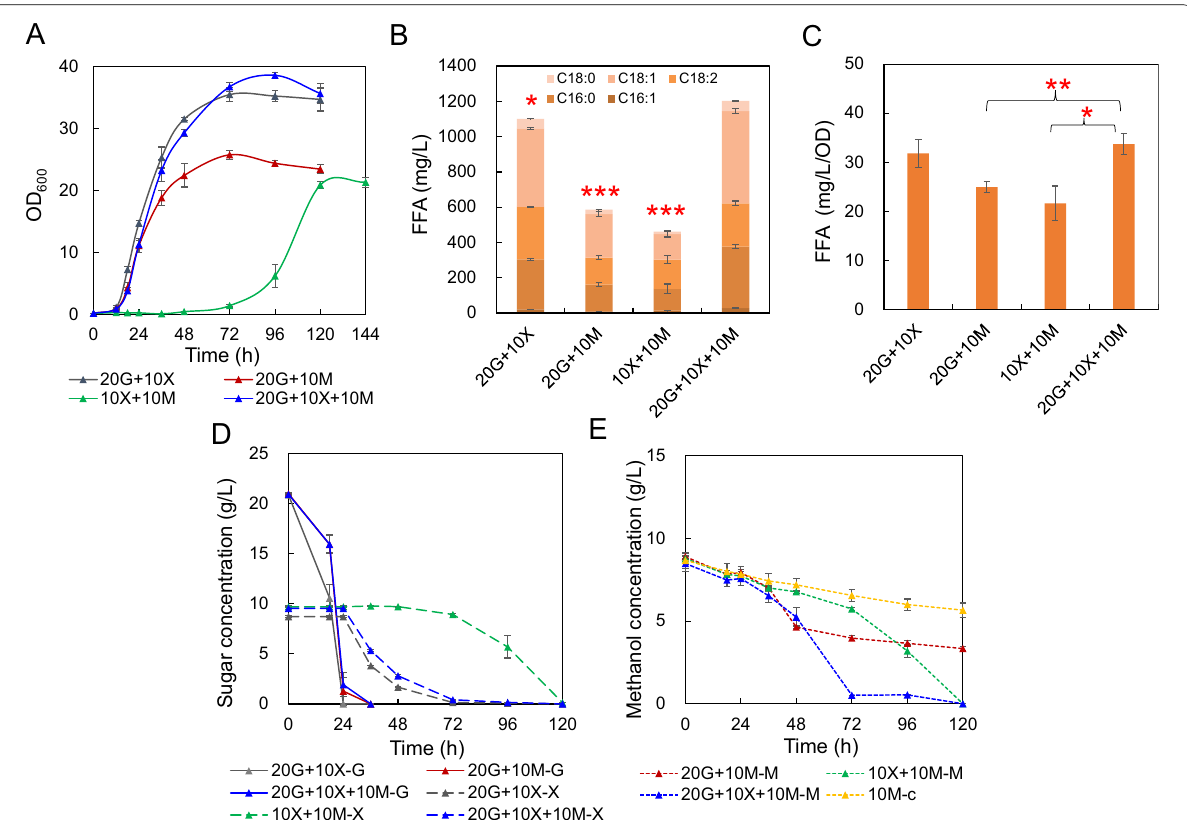
Fig. 6 Co-feed of glucose, xylose and methanol for FFA production in strain FD09. A Growth curve of strain FD09 in different carbon sources. 20G 10X: 20 g/L glucose and 10 g/L xylose, 20G 10 M: 20 g/L glucose and 10 g/L methanol, 10X 10 M: 10 g/L xylose and 10 g/L methanol, + + + 20G 10X 10 M: 20 g/L glucose, 10 g/L xylose and 10 g/L methanol; Strains were cultivated in minimal media containing above substrates, and + + samples were taken to measure FFA titers. B FFA titers of strains cultivated in minimal media containing above substrates. Red asterisks indicate statistical significance as determined by paired t test (*P < 0.05; ***P < 0.001). C Specific FFA production rate of strains cultivated in minimal media containing above substrates. Red asterisks indicate statistical significance as determined by paired t test (*P < 0.05; **P < 0.01). D Sugar concentration ( G: glucose concentration, X: xylose concentration). E Methanol concentration (M: methanol concentration, 10 M-c: control of methanol volatilization). Data are presented as mean s.e.m. (n 3 biologically independent ± =